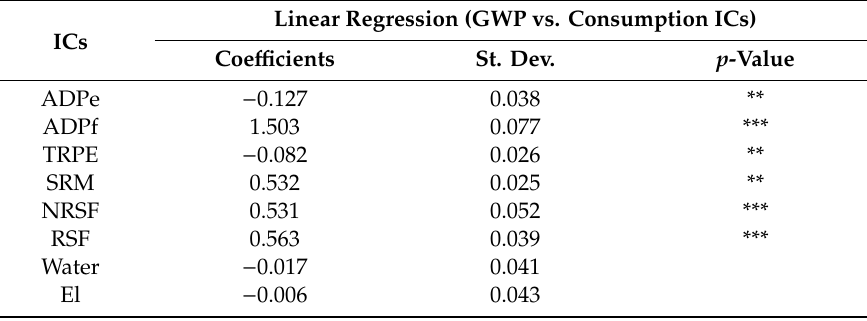
Table 5. Linear regression summary (GWP vs. Consumption ICs).